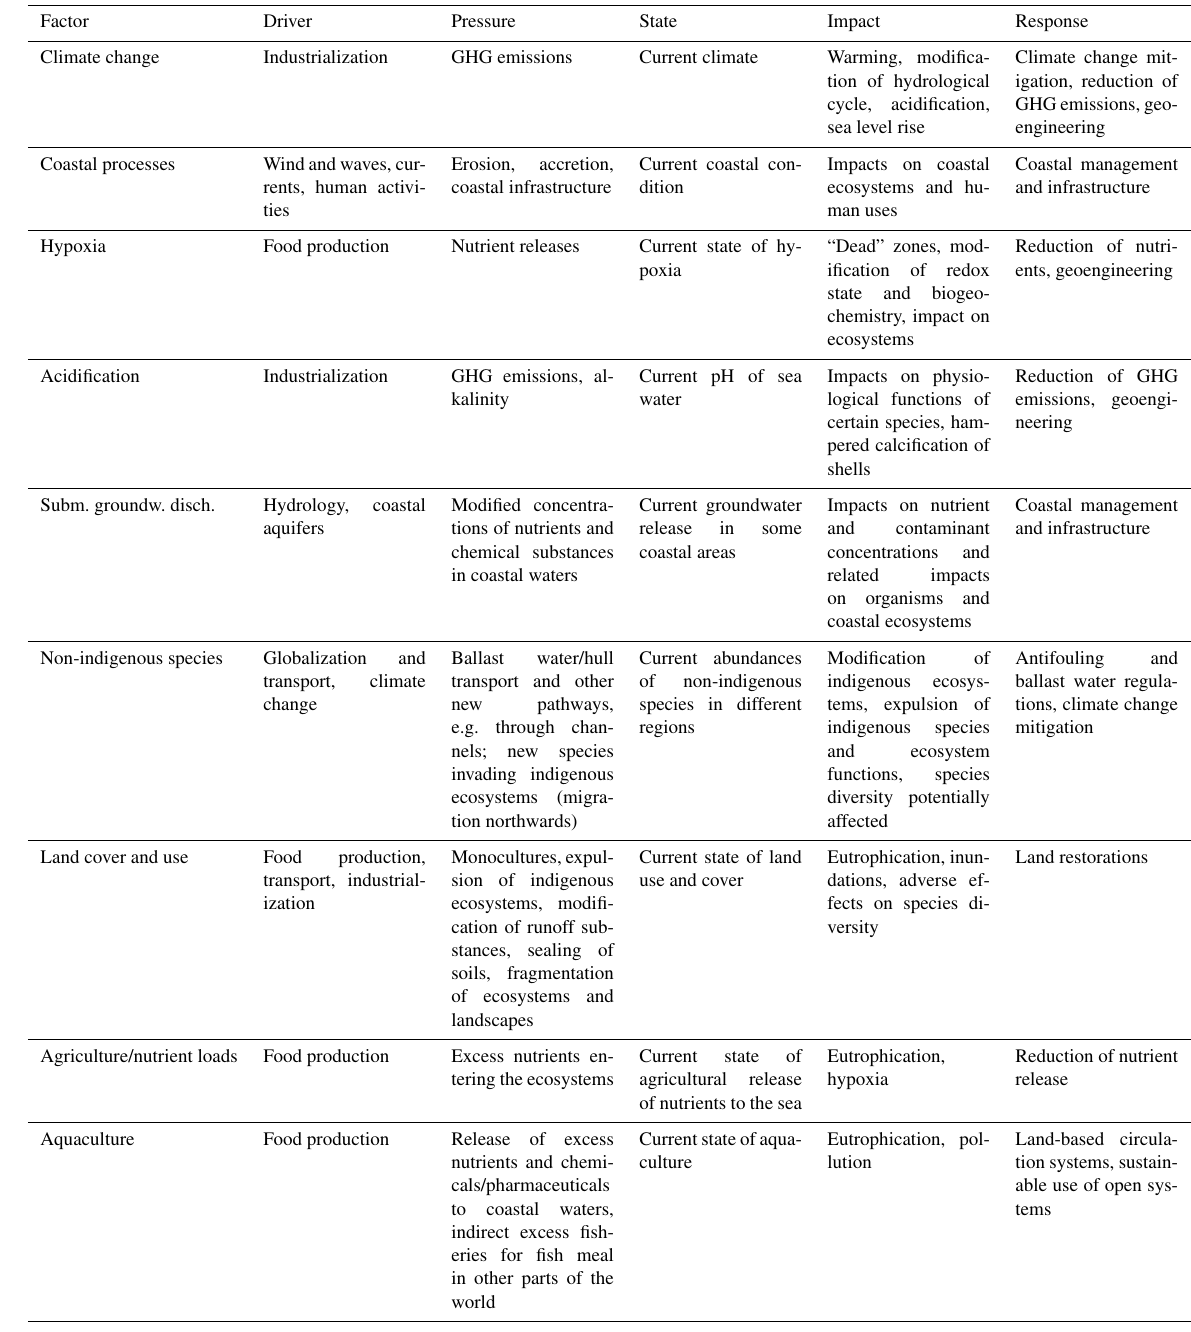
Table 1. Matrix of different factors using the DPSIR analysis (drivers, pressures, states, impacts, responses). For a thorough description of the DPSIR concept, see Smeets and Weterings (1999) and Gari et al.